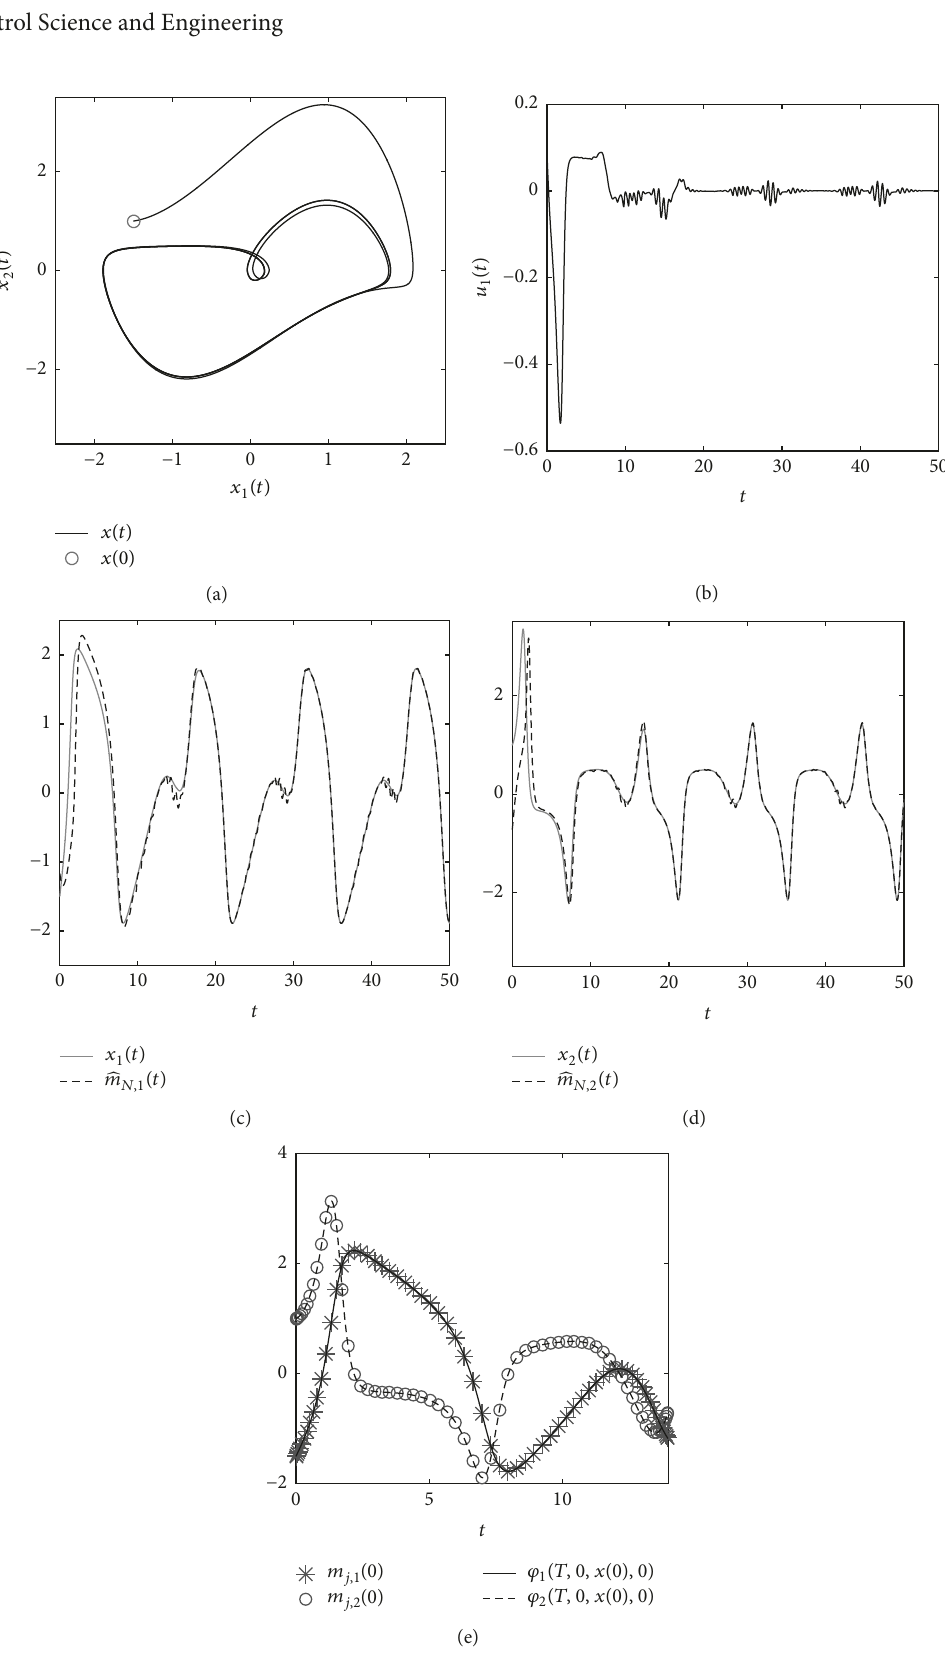
Figure 11: aPBC applied with 𝑁 = 67 , 𝑘 = 0.25 , and 𝑘 𝑜 = 10 . (a) Trajectory in state space; (b) time-series of the control signal; ((c) and (d)) time-series of the actual and predicted state variables; (e) time-series of 𝜑(𝑇,0, 𝑥(0),0) and the initial value of the predicted states 𝑚 𝑗 (0)